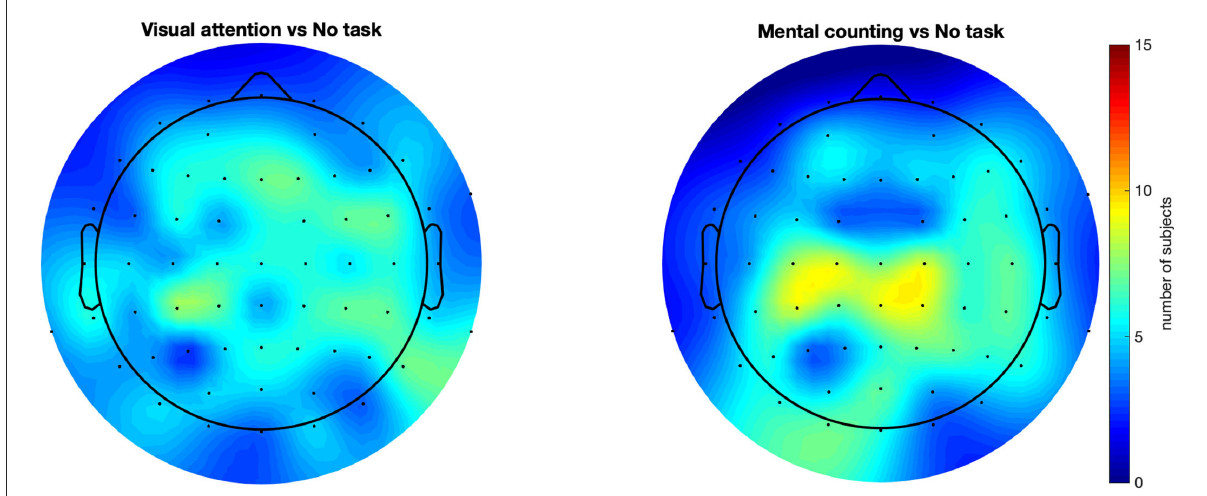
FIGURE4 Scalp plots representing for how many subjects each electrode was included in a statistically significant cluster. All compared conditions had regular flickering. This figure suggests a consistency in the results across subjects, showing that majority of the subjects had an anterior propagation of the entrainment with introducing a cognitive task. These results also strengthen the observation in Figure 3 (the spatial distribution for task-conditions), but in this case in a single subject case